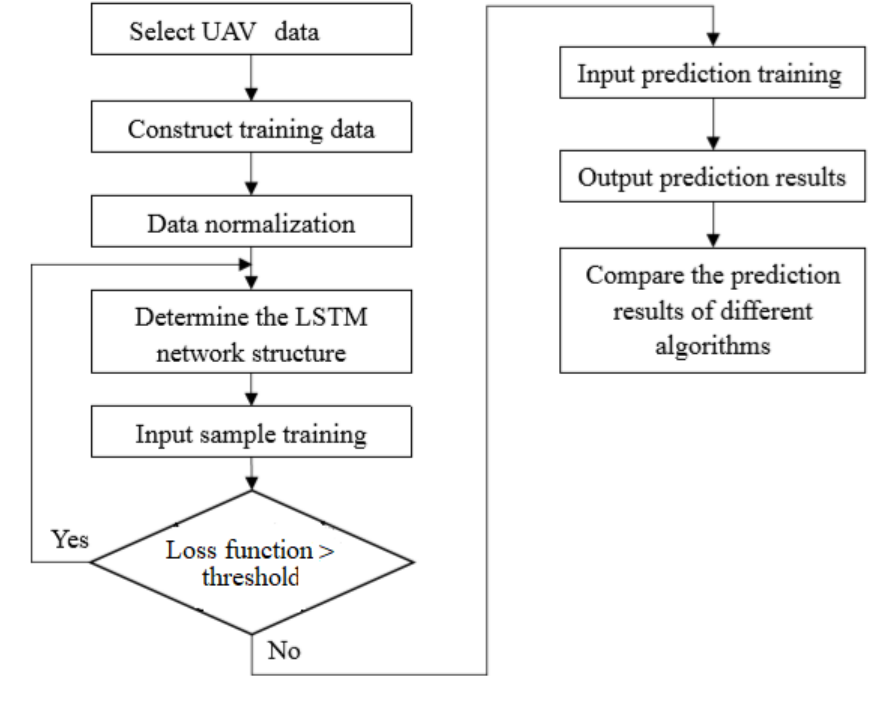
Figure 5. Algorithm flow